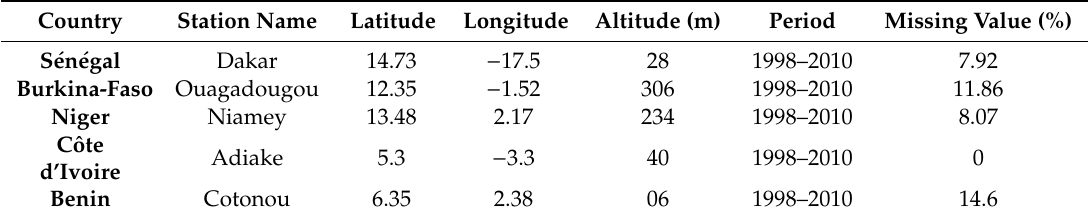
Table 1. Data used for validation.